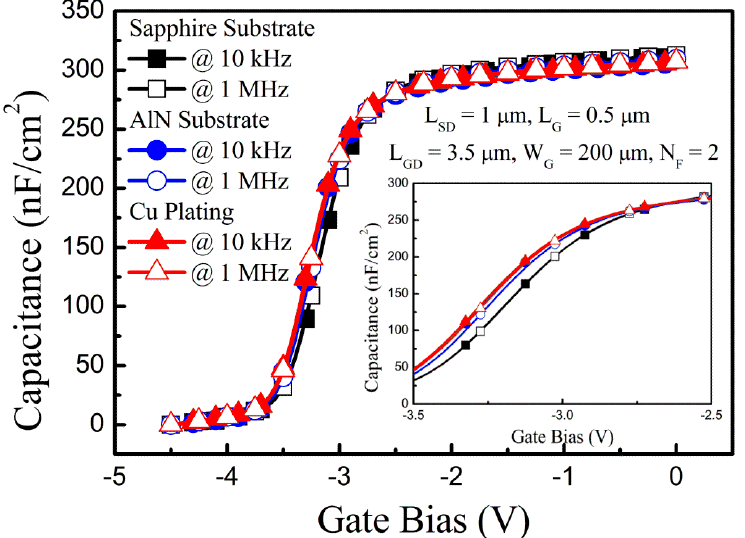
Figure 5. C(V) measurement results. Capacitance vs. gate bias at 10 kHz and 1 MHz for sapphire substrate, AlN substrate, and Cu film. Inset shows the zoomed-in C(V) curves at −3.5 V ≤ V G ≤ − 2.5 V.